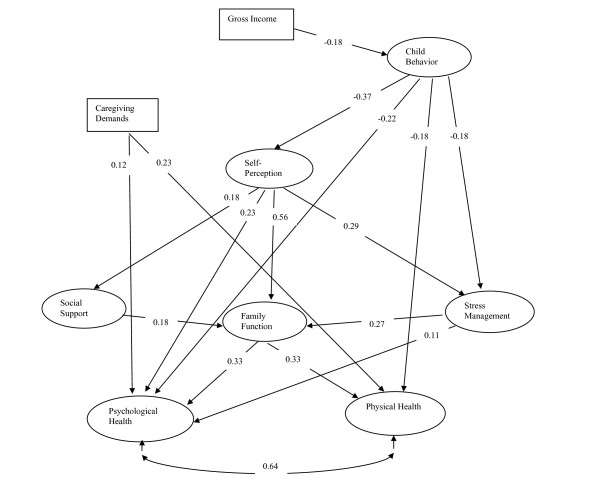
Structural (path) model of factors influencing the health of caregivers: standardized path coefficients appear on single-headed arrows. Correlations of the residual term of Psycho and Physical latent variables appear on curved double-headed arrows.